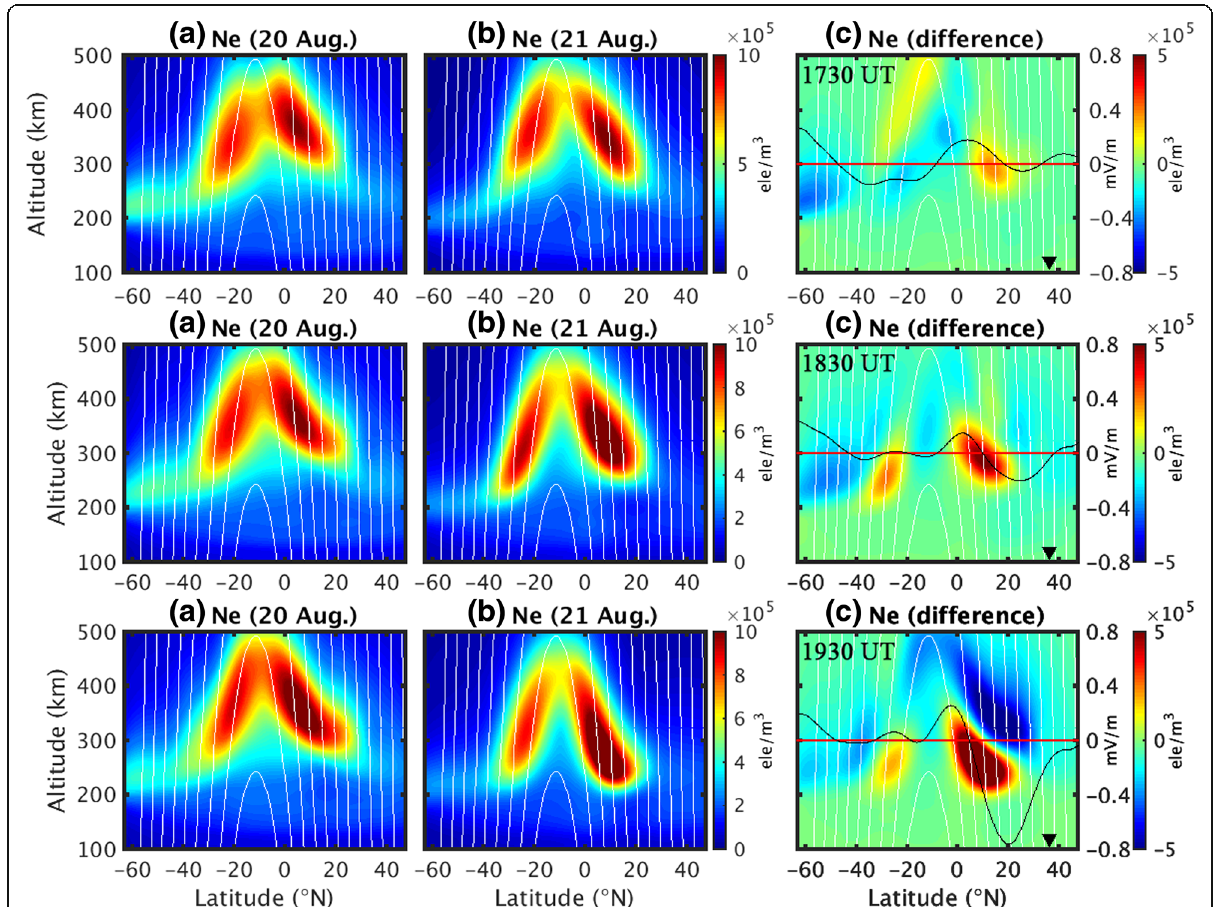
Fig. 2 The altitude-latitude variations of electron density profile from the assimilation results on the eclipse previous day ( a ) and the eclipse day ( b ) and the difference ( c ) between the results of a and b , along the magnetic field line (shown in the bottom panel of Fig. 1d) at 1730 UT (top panels), 1830 UT (middle panels), and 1930 UT (bottom panels), respectively. The black line in c indicates the electric field perturbations between the eclipse day and the previous